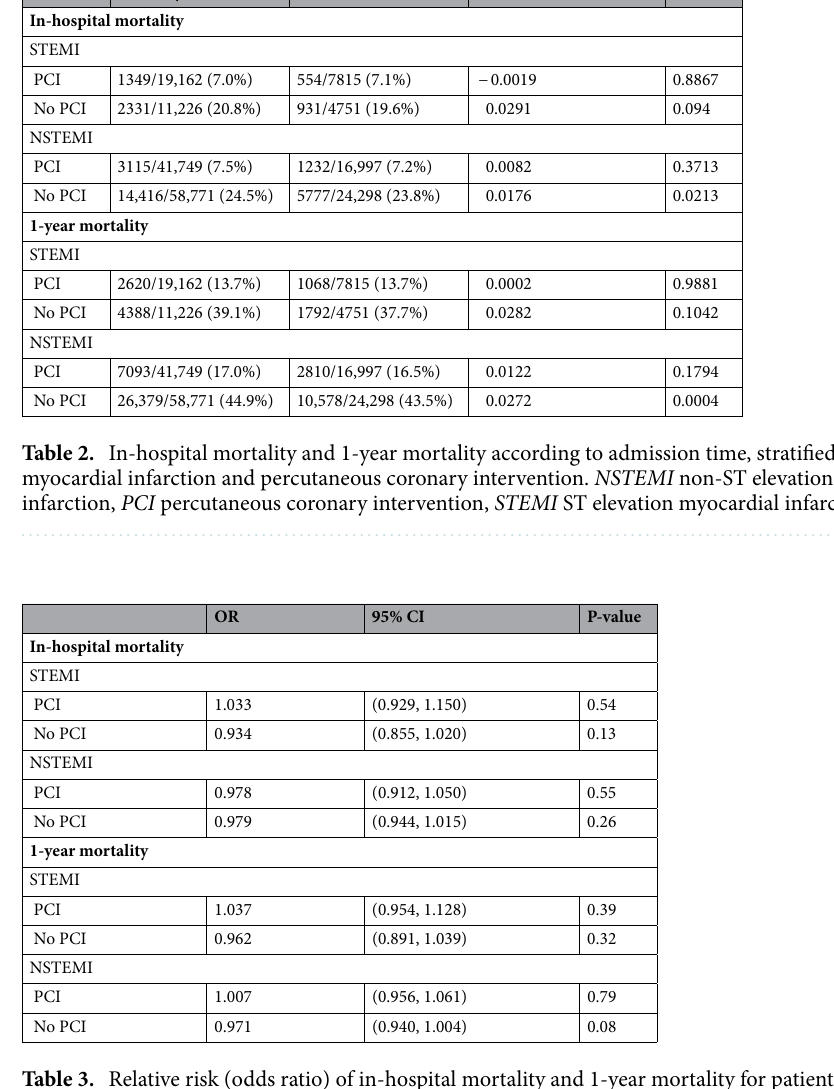
Table 3 shows the results of the multivariate logistic regression analysis stratified by the subtypes of myo- cardial infarction and whether or not executing PCI after adjusting for all the covariates. Among the STEMI subgroup, there was no difference between the weekend group and weekday group with respect to risk of in- hospital mortality (with PCI: adjusted OR 1.033, 95% confidence interval [CI] 0.929–1.150, p = 0.54; without